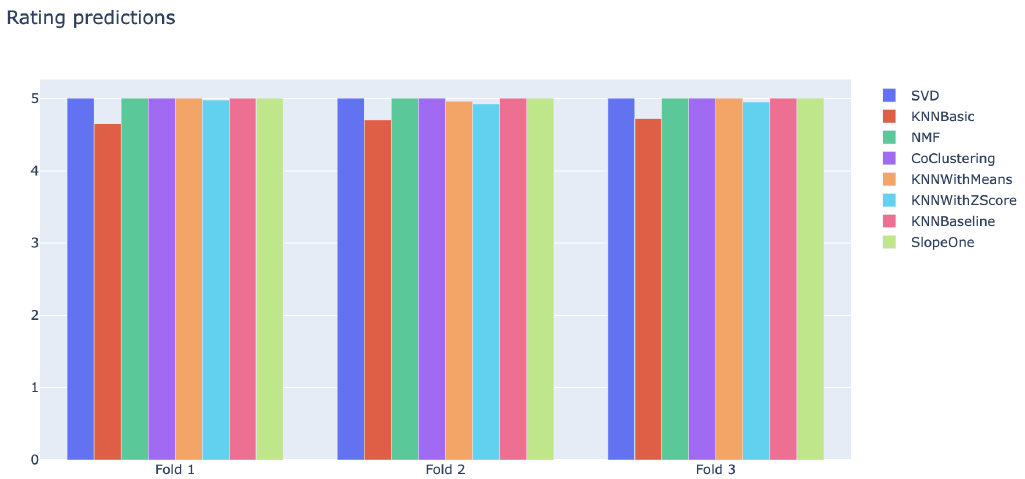
Figure 10. Rating prediction results using all model-based recommendation